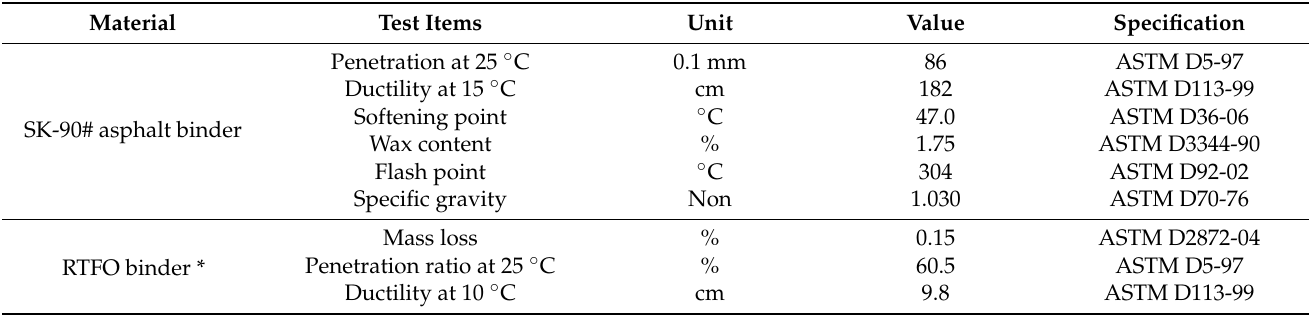
Table 1. Technical properties of SK-90# asphalt binder.